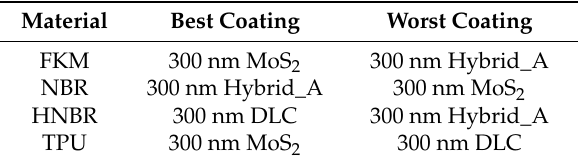
Table 7. The best and worst coating for each material from ball on disc